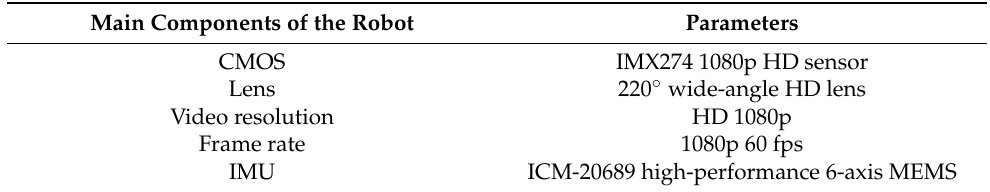
Table 1. Main parameters of the capsule robot.